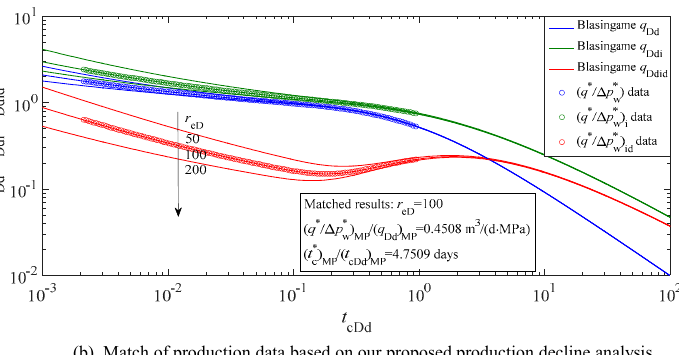
(b) Match of production data based on our proposed production decline Figure 16. Match of production data for CRP case of q = 20 m 3 Figure 16. Match of production data for CRP case of 3 20 m d = q .